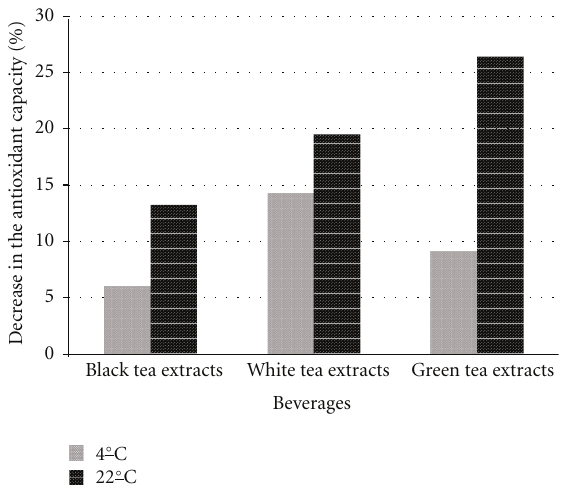
Figure 1: Decrease in the antioxidant capacity in the stored beverages in %, day 0–4.